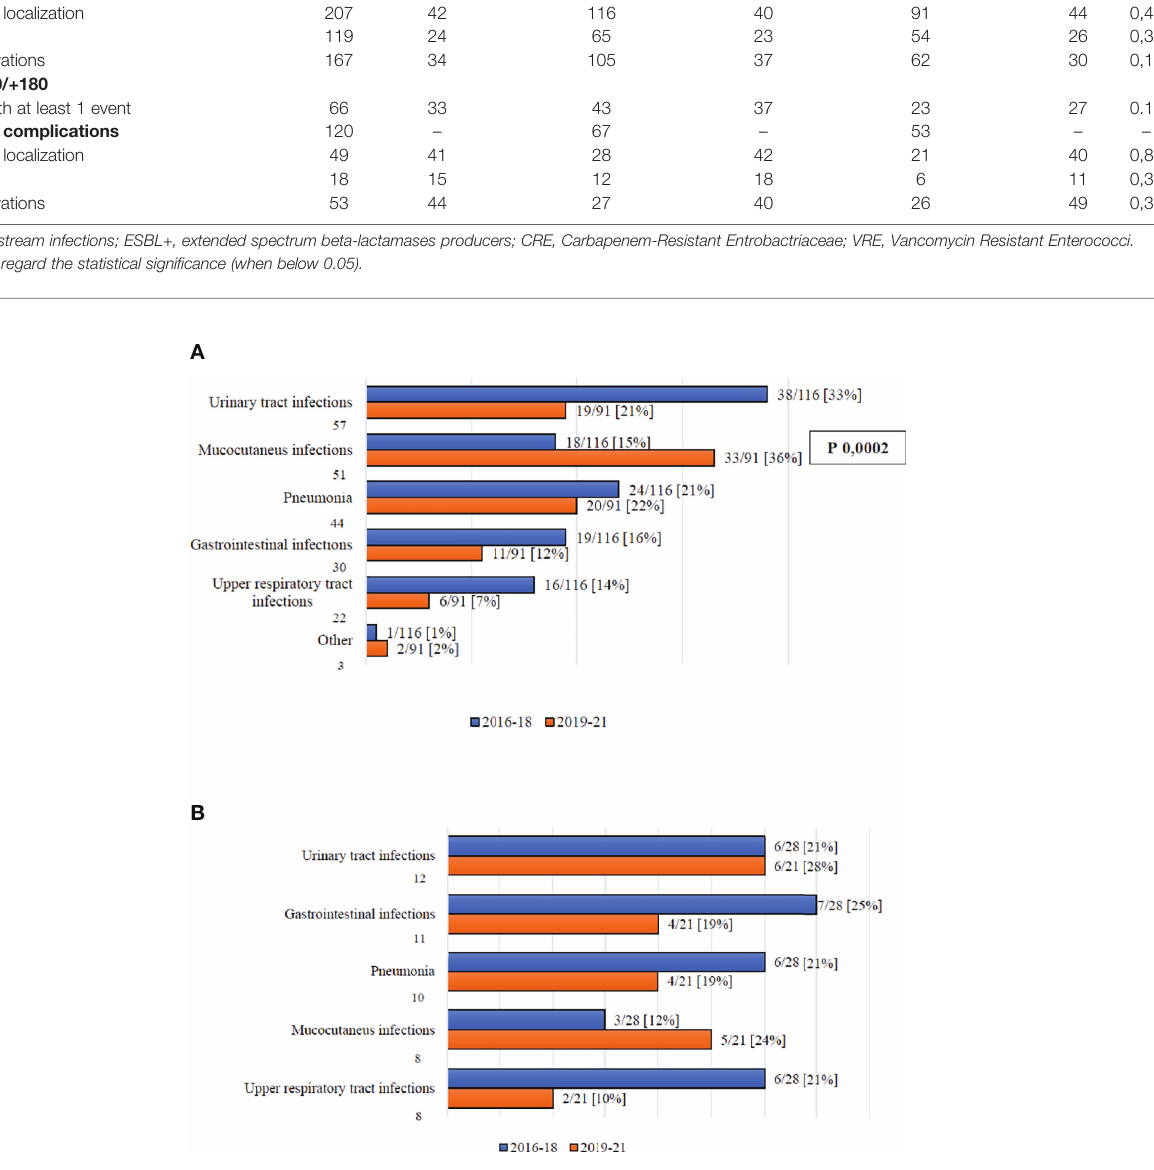
FIGURE 1 | (A) Infection complications with organ localization by day +100. (B) Infection complications with organ localization between day +100 and +180.